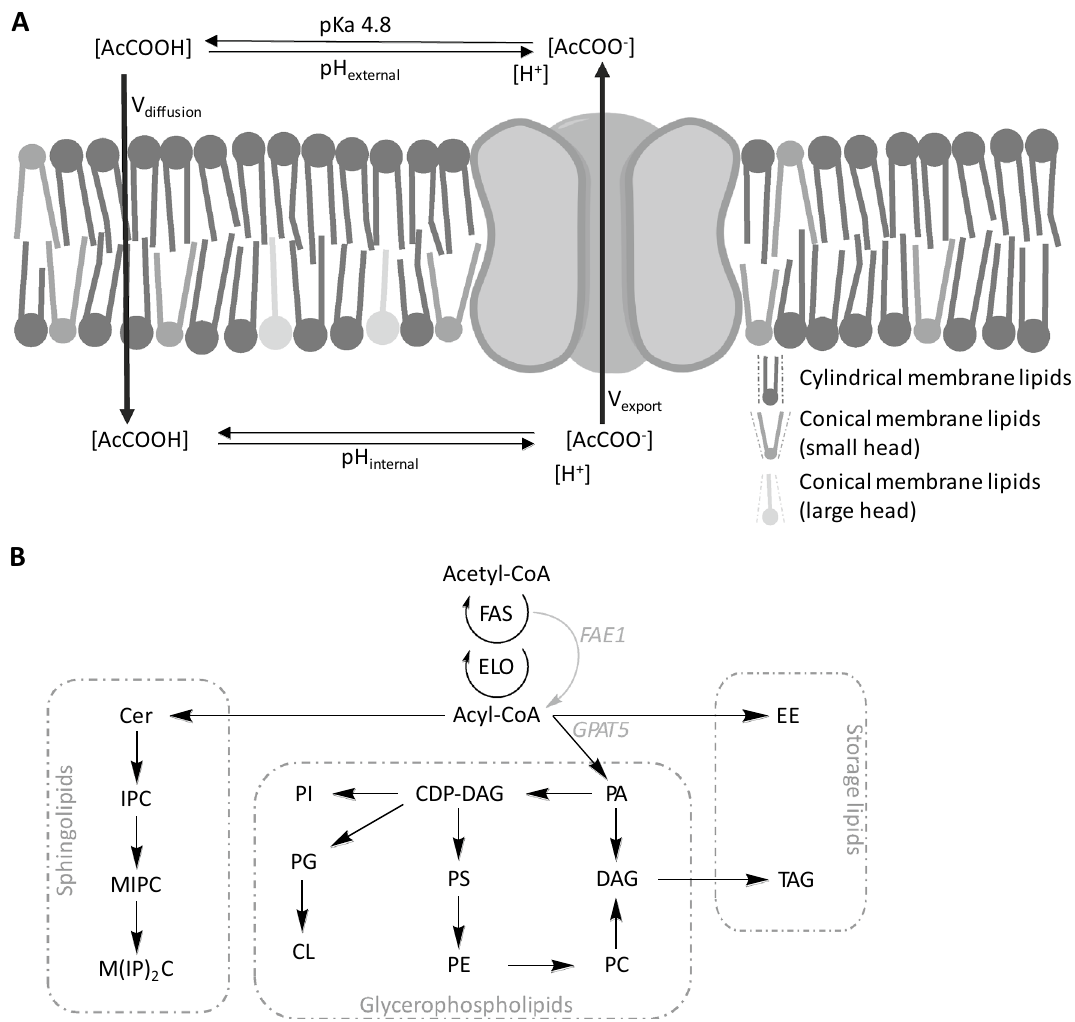
Figure 1. Membrane composition, acetic acid homeostasis and lipid metabolism. Membrane composition and structure are illustrated in panel ( A ). The undissociated form of acetic acid can diffuse passively across the lipid bilayer, while the dissociated form is actively removed from the cell by the transporters Pma1 and Tpo3. Chemical equilibrium exists between the dissociated and undissociated forms of acetic acid both inside and outside the cell, depending on the pH (pKa ~ 4.8). Intracellular concentration is dependent on the equilibrium of undissociated form inside and outside the cell. The plasma membrane is composed of cylindrical (sphingolipids, PC, PS, PI) and conically shaped lipids (with a small head: DAG, PA, PE; or a large head: lyso- glycerophospholipids). A simplified illustration of S. cerevisiae lipid metabolism is shown in panel ( B ) (chemical structures: additional file 1, S10). The Arabidopsis thaliana genes used in strain engineering ( FAE1 , GPAT5 ) are shown in grey. AcCOO- acetate, AcCOOH acetic acid, CDP-DAG cytidine diacylglycerol, Cer ceramides, CL cardiolipin, DAG diacylglycerol, EE ergosterol ester, ELO fatty acid elongation, FAE1 , ( Arabidopsis thaliana ) fatty acid elongase 1; FAS, (de novo) fatty acid synthesis; GPAT5 , ( Arabidopsis thaliana ) glycerol-3- phosphate acyltransferase 5; IPC inositol phosphorylceramide; M(IP) 2 C, mannosyl-di-(inositol phosphoryl) ceramide, MIPC mannosyl-inositol phosphorylceramide, PA phosphatidic acid, PC phosphatidylcholine; PE phosphatidylethanolamine, PG phosphatidylglycerol; PI phosphatidylinositol, PS phosphatidylserine, TAG